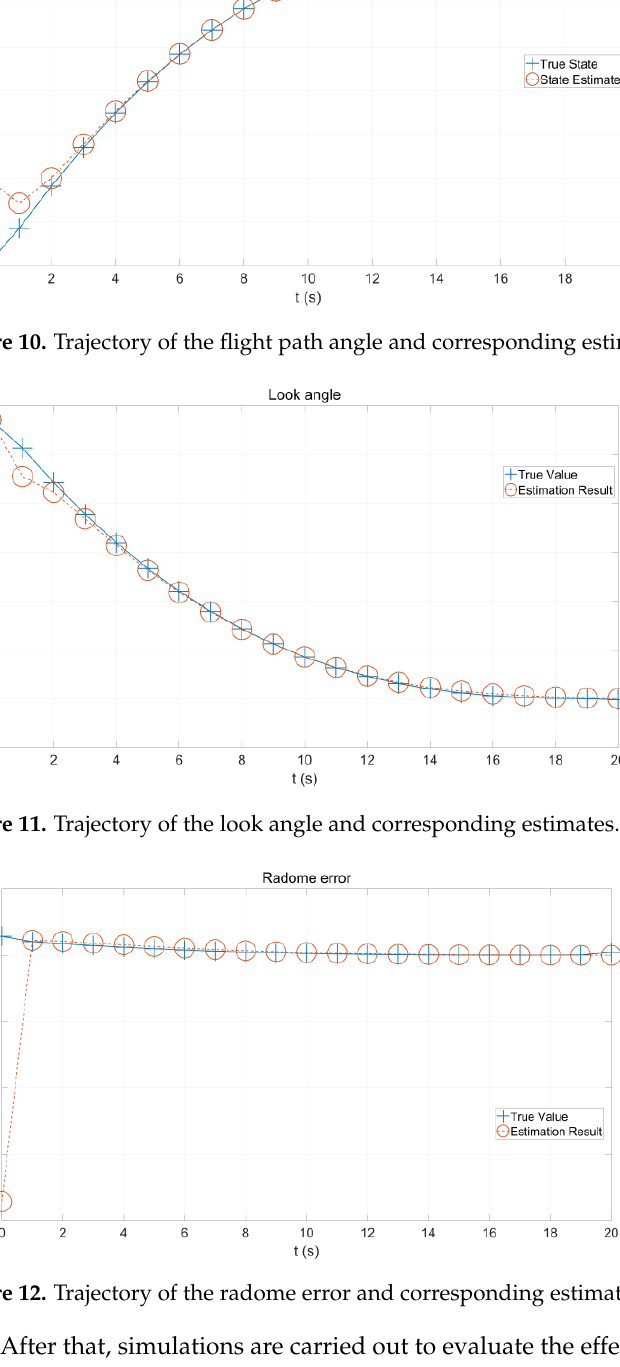
Figure 12. Trajectory of the radome error and corresponding estimates.